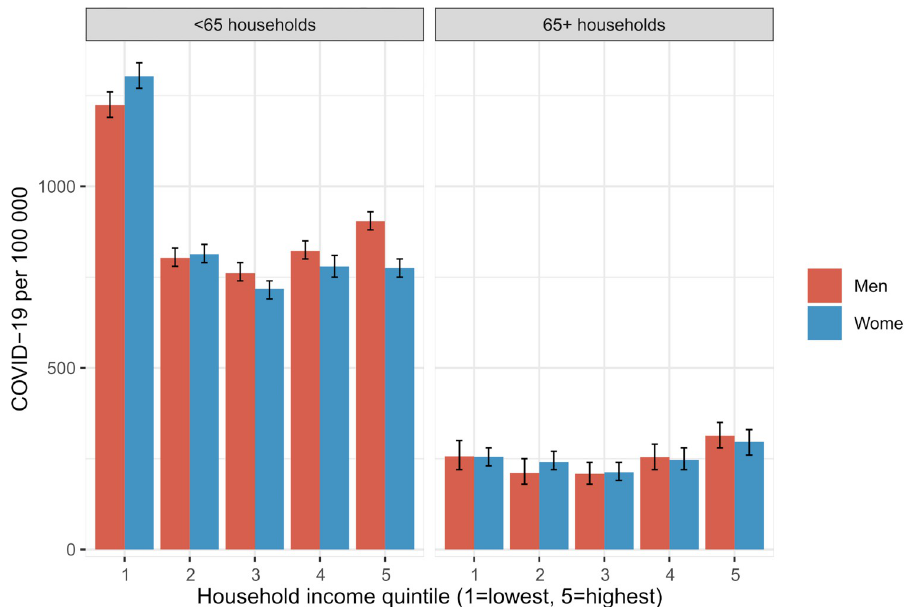
Fig 2. COVID-19 incidence by sex and household income quintile. Incidence per 100,000 from 1 July 2020 to 22 February 2021 among individuals living in households with people aged under 65 and over 65. The whiskers represent 95% confidence